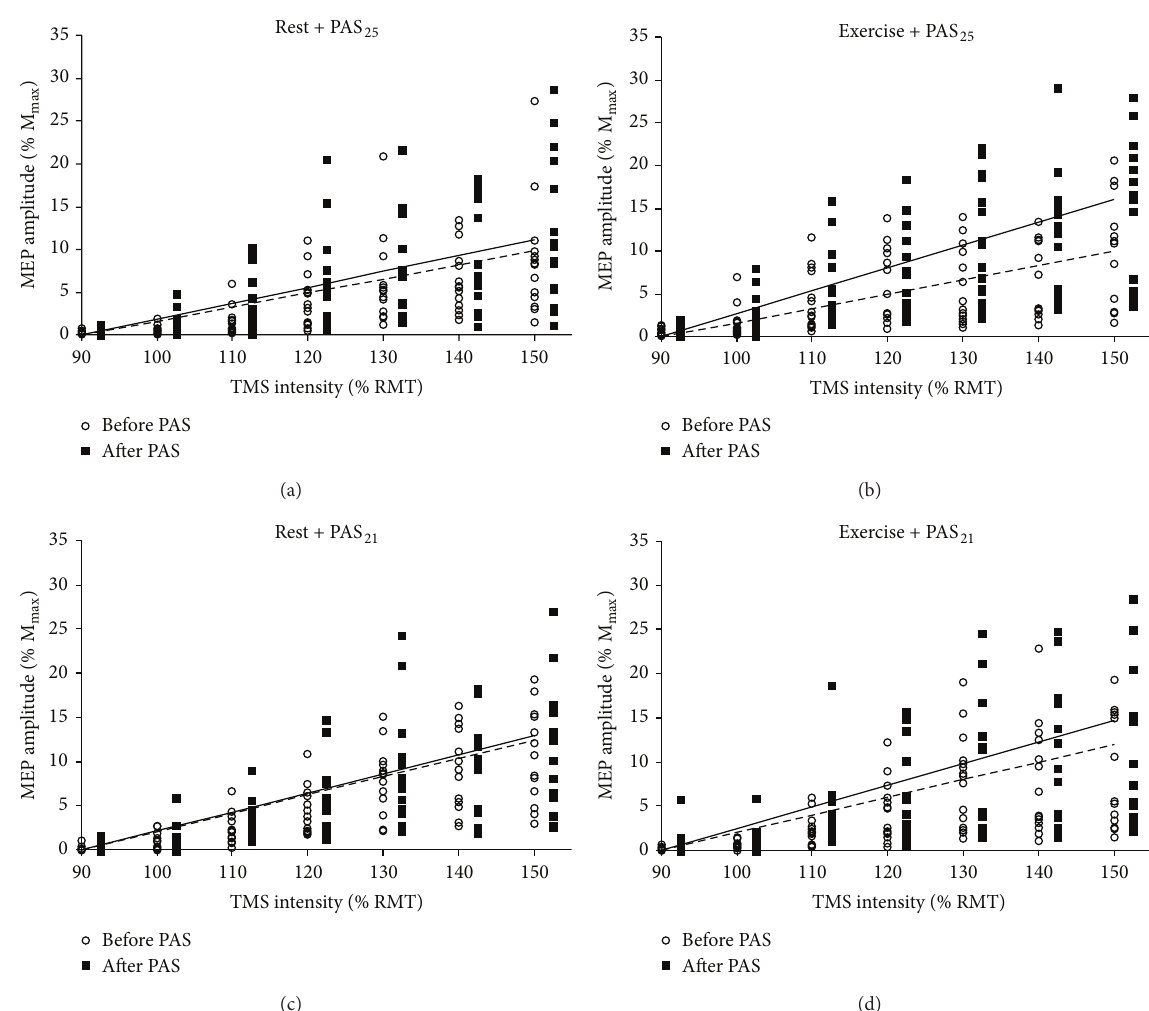
Figure 4: MEP recruitment curve data before and after PAS under rest (a and c) and aerobic exercise conditions (b and d) for each participant inboththePAS 25 (aandb)andPAS 21 (candd)groups.UnfilledcirclesandfilledsquaresdepictMEPamplitudeateachstimulatorintensityfor each participant at pre- and post-PAS time points, respectively. Likewise, dashed and solid lines depict linear regression lines showing average recruitment curve slope for the group at pre- and post-PAS time points, respectively. MEP: motor evoked potential; M max : maximal motor- wave; PAS 25 : paired associative stimulation with 25 ms interstimulus interval; PAS 21 : paired associative stimulation with 21ms interstimulus interval; TMS: transcranial magnetic stimulation; RMT: resting motor